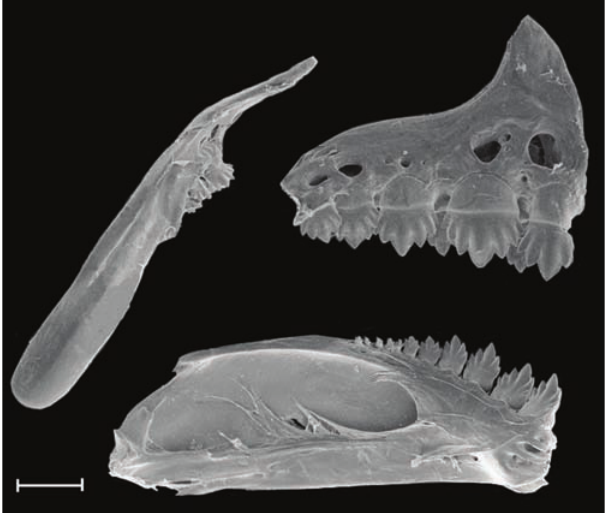
Fig. 2. Scanning electronic micrography of Hemigrammus machadoi , new species, MZUSP 95365, paratype, 27.2 mm SL, left internal lateral view of premaxilla, maxilla and dentary. Scale bar = 1 possessing a distinct dark humeral blotch ( vs . humeral blotch absent) and by lacking a blotch on caudal peduncle or any distinct patch of pigmentation on caudal fin ( vs . dark blotch on caudal peduncle present in H. boesemani and H. geisleri , a dark marking present at the basis of each caudal-fin lobe basis in H. mimus ). Hemigrammus machadoi can be distinguished